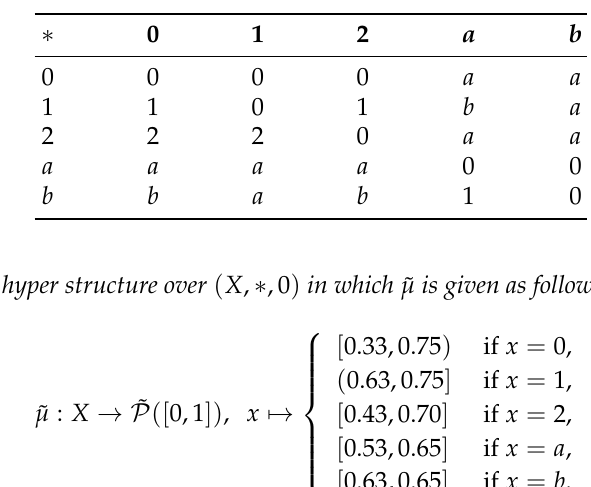
Table 2. Cayley table for the binary operation “ ∗